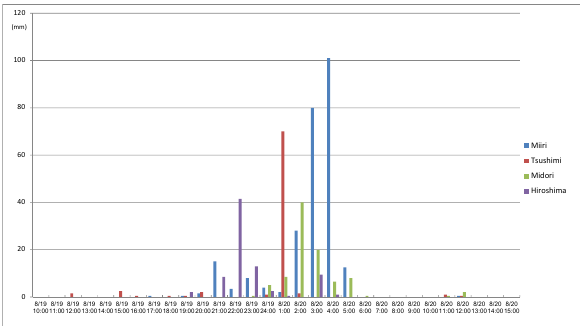
Figure 4. Accumulated precipitation for one hour of Hiroshima Prefecture region of JMA